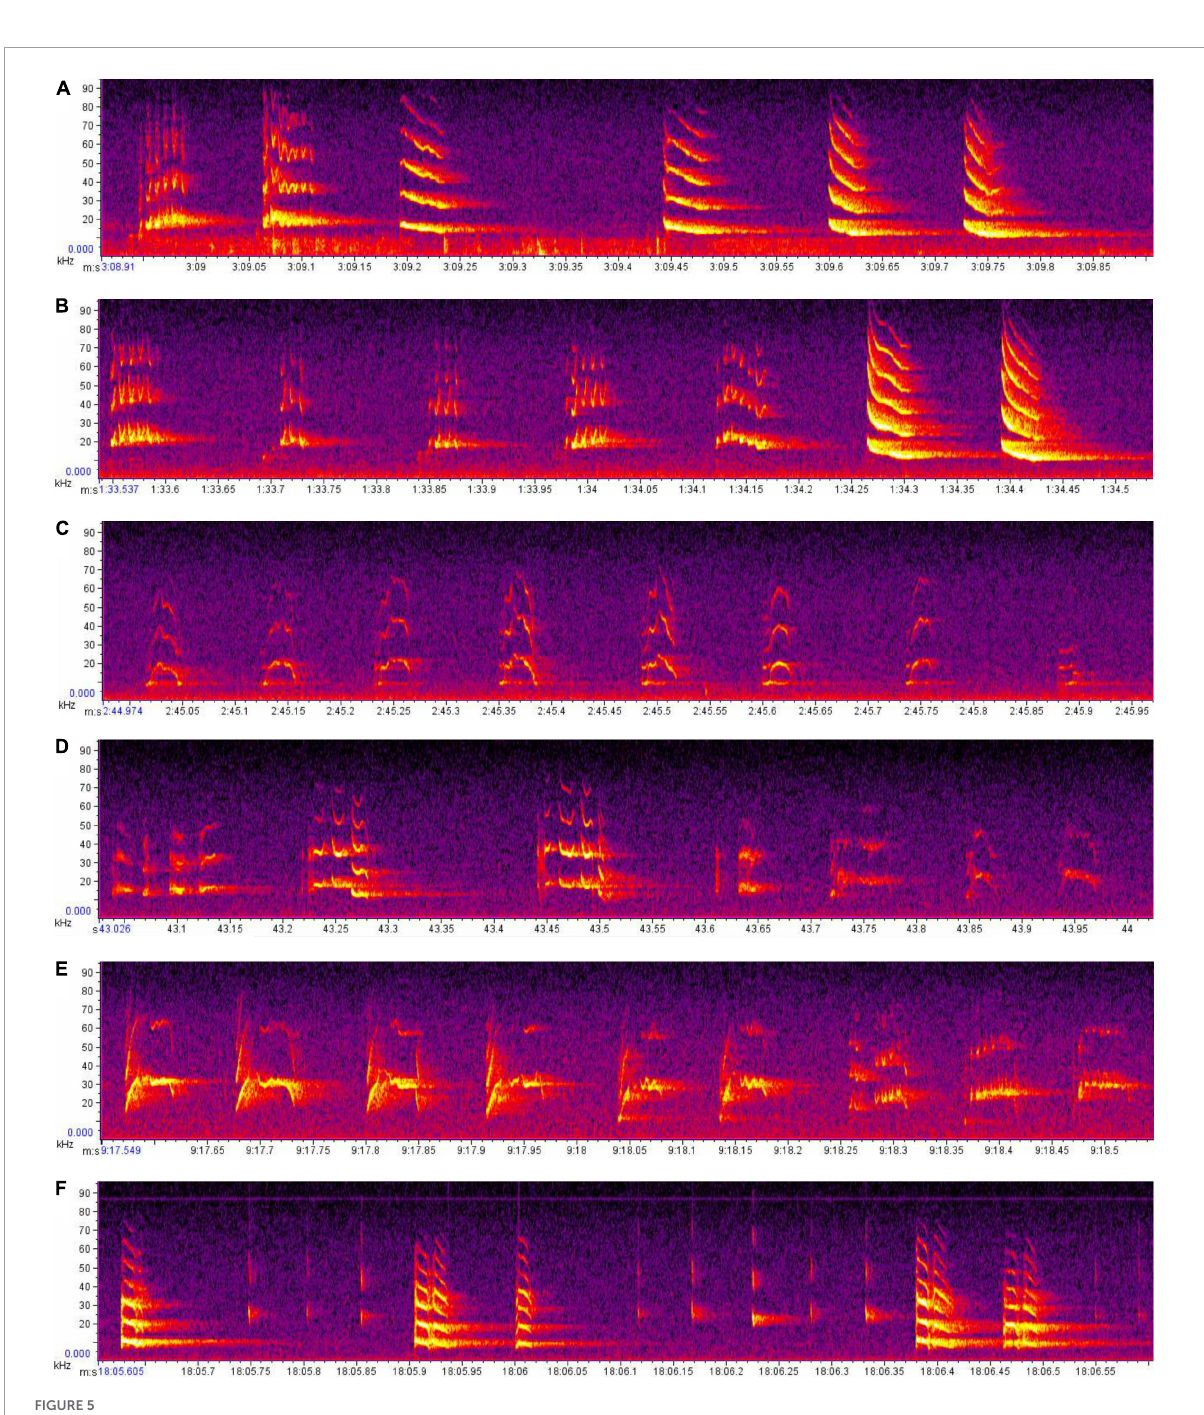
FIGURE5 Spectrogram images of demonstrating variation in call structures within and between the songs of different Mystacina tuberculata males. Three excerpts (A–C) are taken from the song of the same male (Nero); and three from different males ( D , Domitian; E , Marcus; and F , Otho). Each excerpt is one second in duration. Note the repeated use of sequential phrases (e.g., C ) and the instances in which one phrase-type morphs into another [e.g., from trill to downsweep (A) or from upsweep-trill-downsweep to upsweep-trill to trill (E) , but also instances in which phrases are followed by others that are totally dissimilar (e.g., B,D